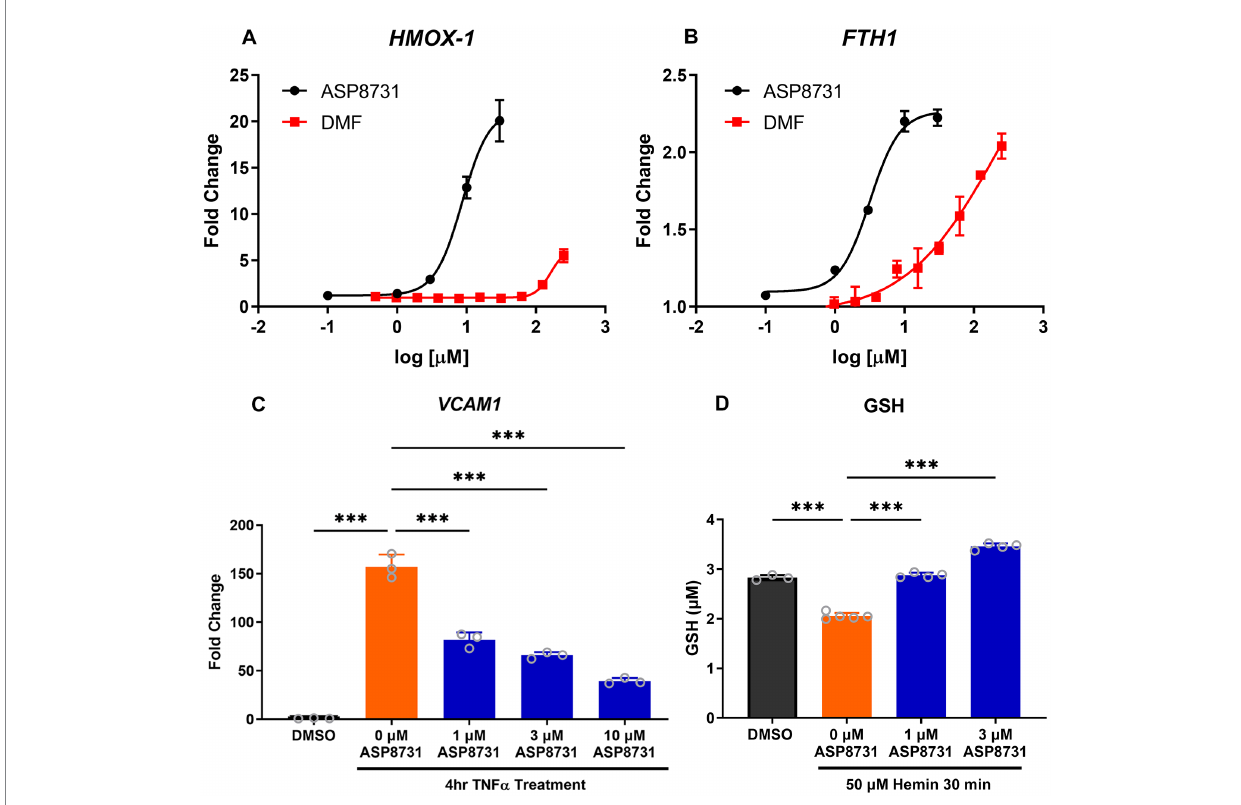
FIGURE 1 BACH1 inhibitor ASP8731 modulated multiple pathways in vitro that are involved in SCD pathophysiology. ASP8731, dimethyl fumarate (DMF), or DMSO vehicle were incubated with HepG2 cells for 24 h and (A) HMOX1 (HO-1) and (B) FTH (ferritin heavy chain) mRNA were measured. (C) Human primary pulmonary arterial endothelial cells (PAEC) were incubated with ASP8731 (1, 3, 10 μ M) or DMSO vehicle for 24 h and then TNF- α (10 ng/ml), was added for an additional 4 h followed by RNA isolation and measurement of VCAM1 mRNA. (D) PAEC were incubated with DMSO vehicle or ASP8731 (0, 1, or 3 μ M) for 24 h and then hemin (50 μ M) was added for an additional 30 min followed by measurement of glutathione (GTH) levels. Values are means ± SEM. *** p < 0.001, one-way ANOVA with Tukey’s multiple comparison